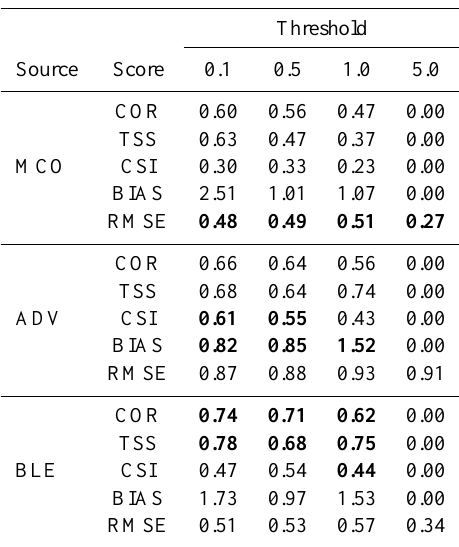
Table A1. Matrix showing the frequencies of predicted and/or ob- served events determined by threshold ( T ). This matix is called contingency